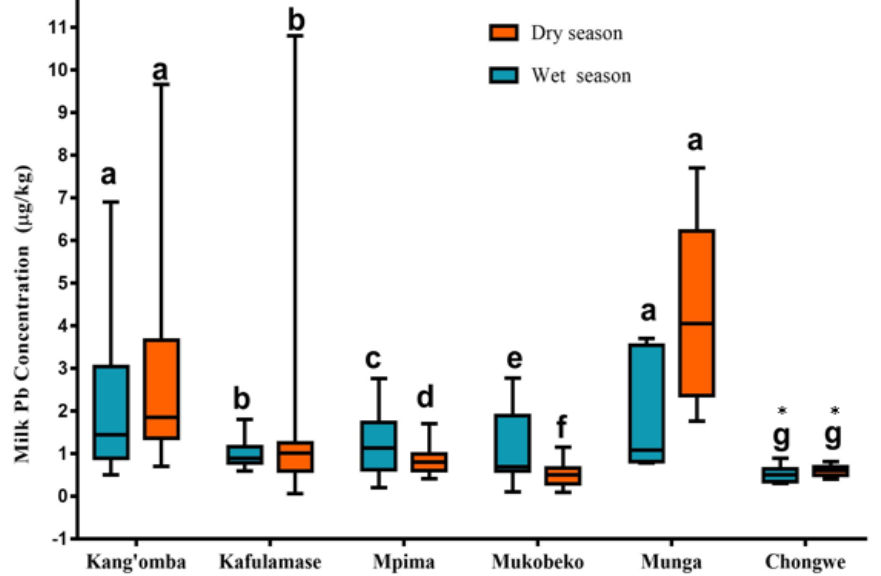
Figure 3. A summary of Pb concentrations ( µ g/kg) in cow milk analyzed from different sites per season in the mining area (Kang’omba, n = 56; Mpima, n = 54; Kafulamase, n = 35; Mukobeko, n = 59; Munga = 10) and in a non-mining area of Chongwe (reference site), n = 18. Data are presented in box and whisker plots: lines marked across the boxes indicate the medians; box limits represent 25th and 75th percentiles; ends of the whisker show minimum and maximum values of Pb concentrations measured. The lower-case letters a–g represent significant differences among the sampled regions using Tukey’s multiple comparison test ( p < 0.05). Asterisk (*), means reference site.